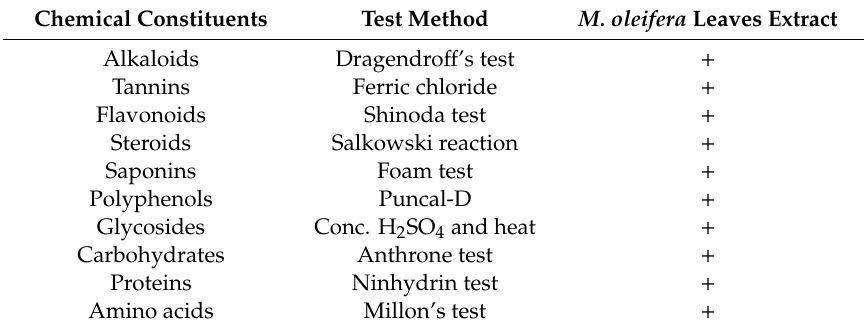
Table 1. Phytochemical analysis of the M. oleifera leaves extract. The presence of the indicated chemical constituents is indicated with ( +